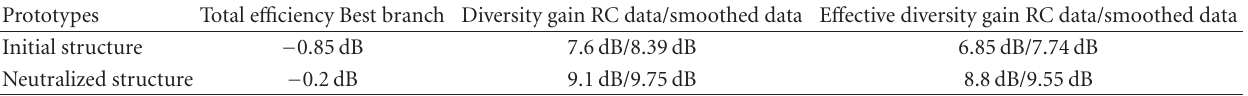
Table 4: Summary of the measured and processed DGs and EDGs of all the antenna systems.